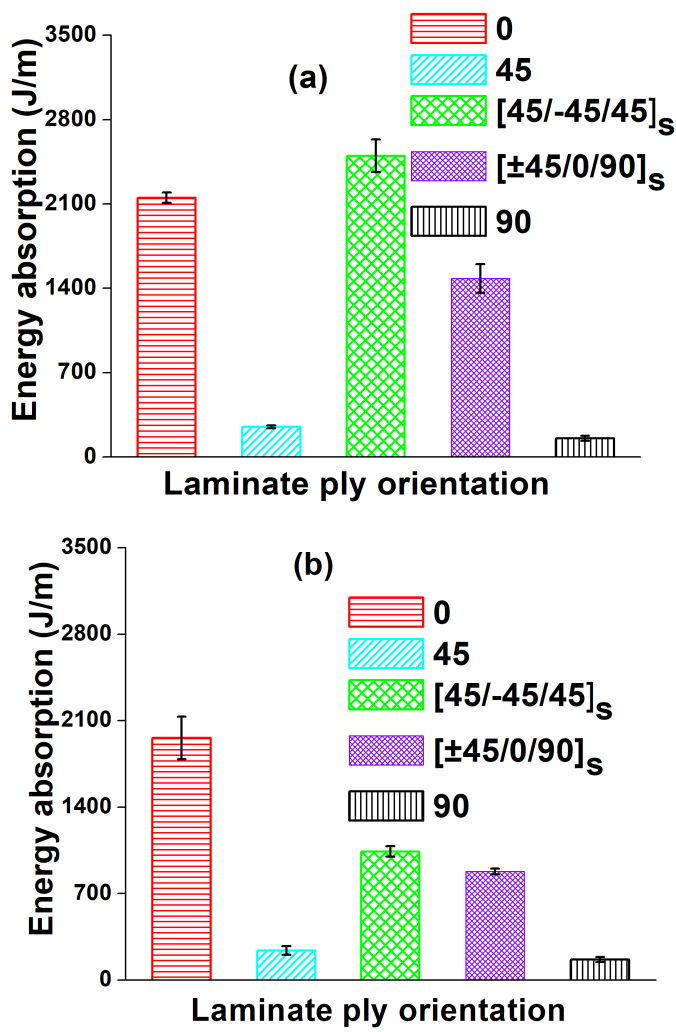
Figure 6. Energy absorption per unit thickness for di ff erent fiber orientations of composites: ( a ) GFRP and ( b ) CFRP.